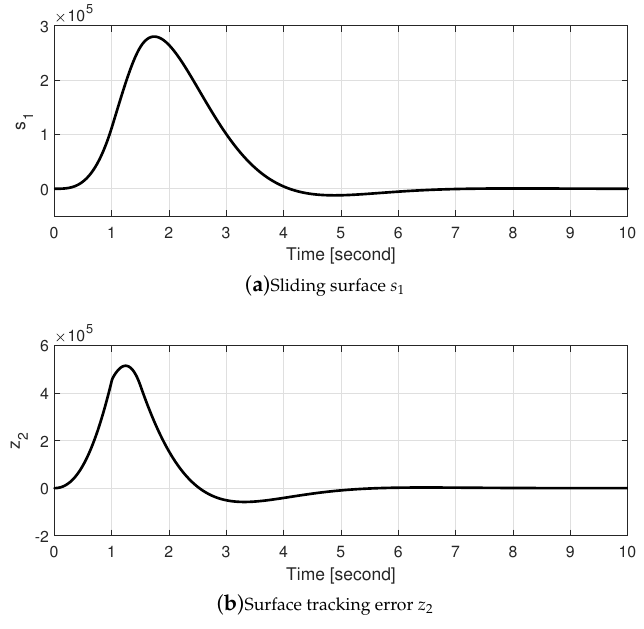
Figure 10. Sliding surface s 1 and surface tracking error z 2 .